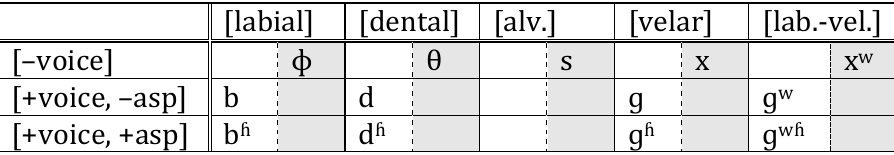
Table 10: The First Germanic Consonant Shift: stage 2 (after step 1).